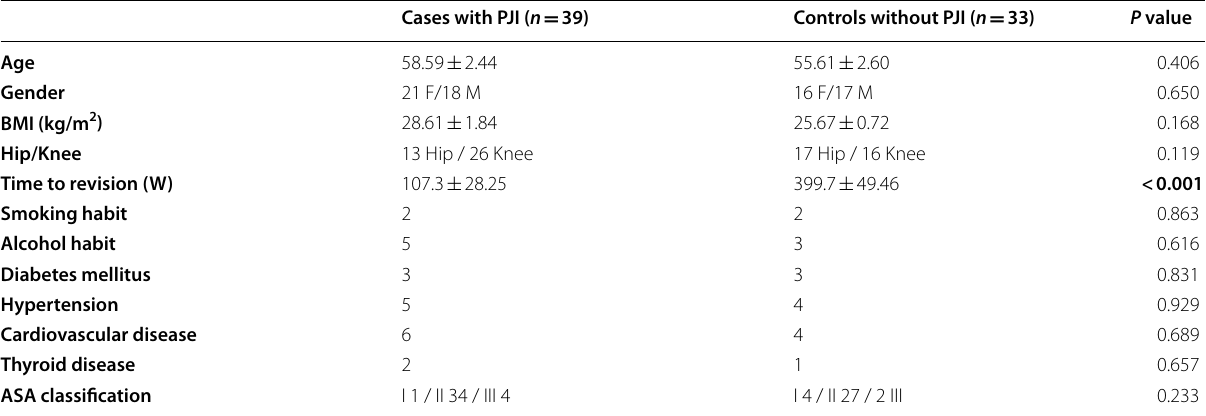
BMI Body mass index, ASA American Society of